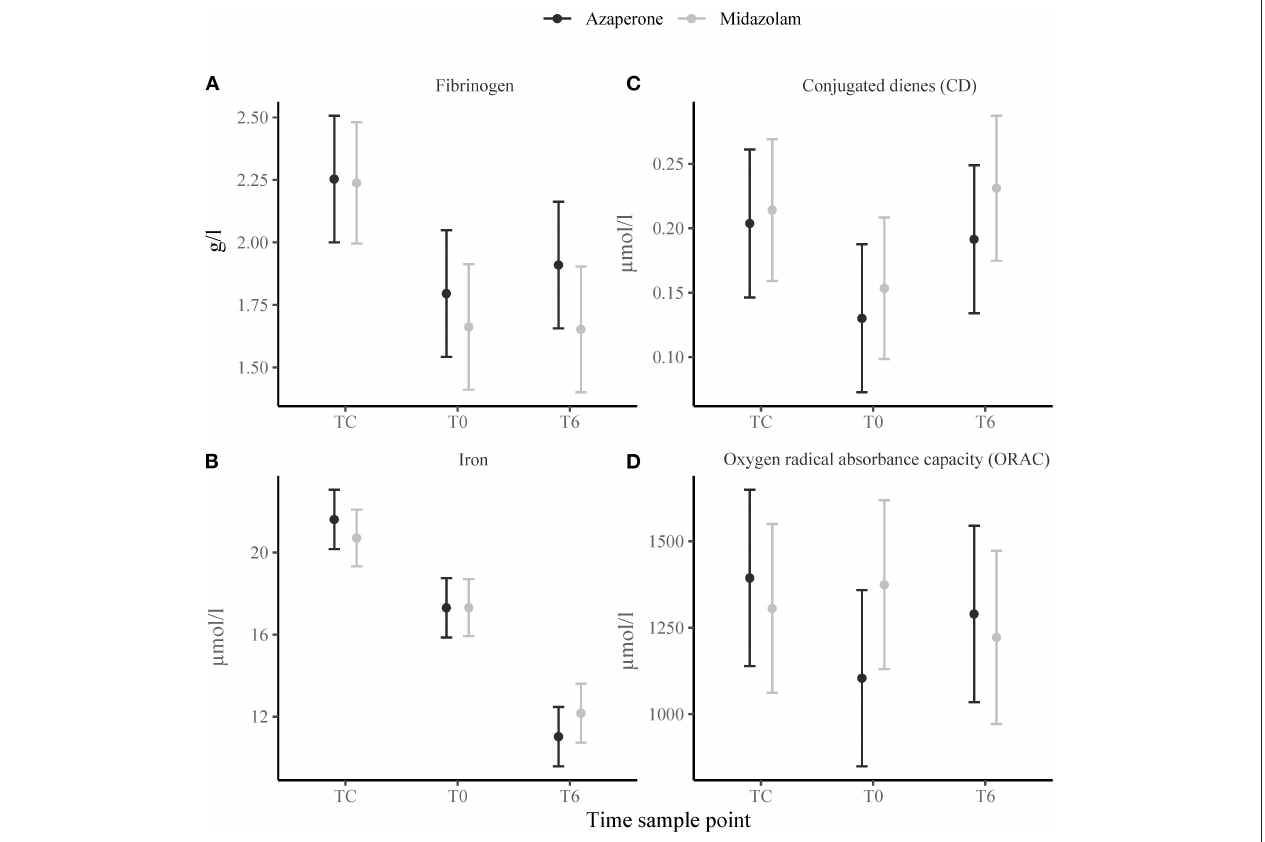
FIGURE 3 | Means ± standard error of immunological variables: (A) fibrinogen, (B) iron, (C) conjugated dienes (CD), (D) oxygen radical absorbance capacity (ORAC) in white rhinoceroses captured and transported with either azaperone or midazolam. Time sample points: capture (TC), start of transport (T0), and 6 (T6) h of